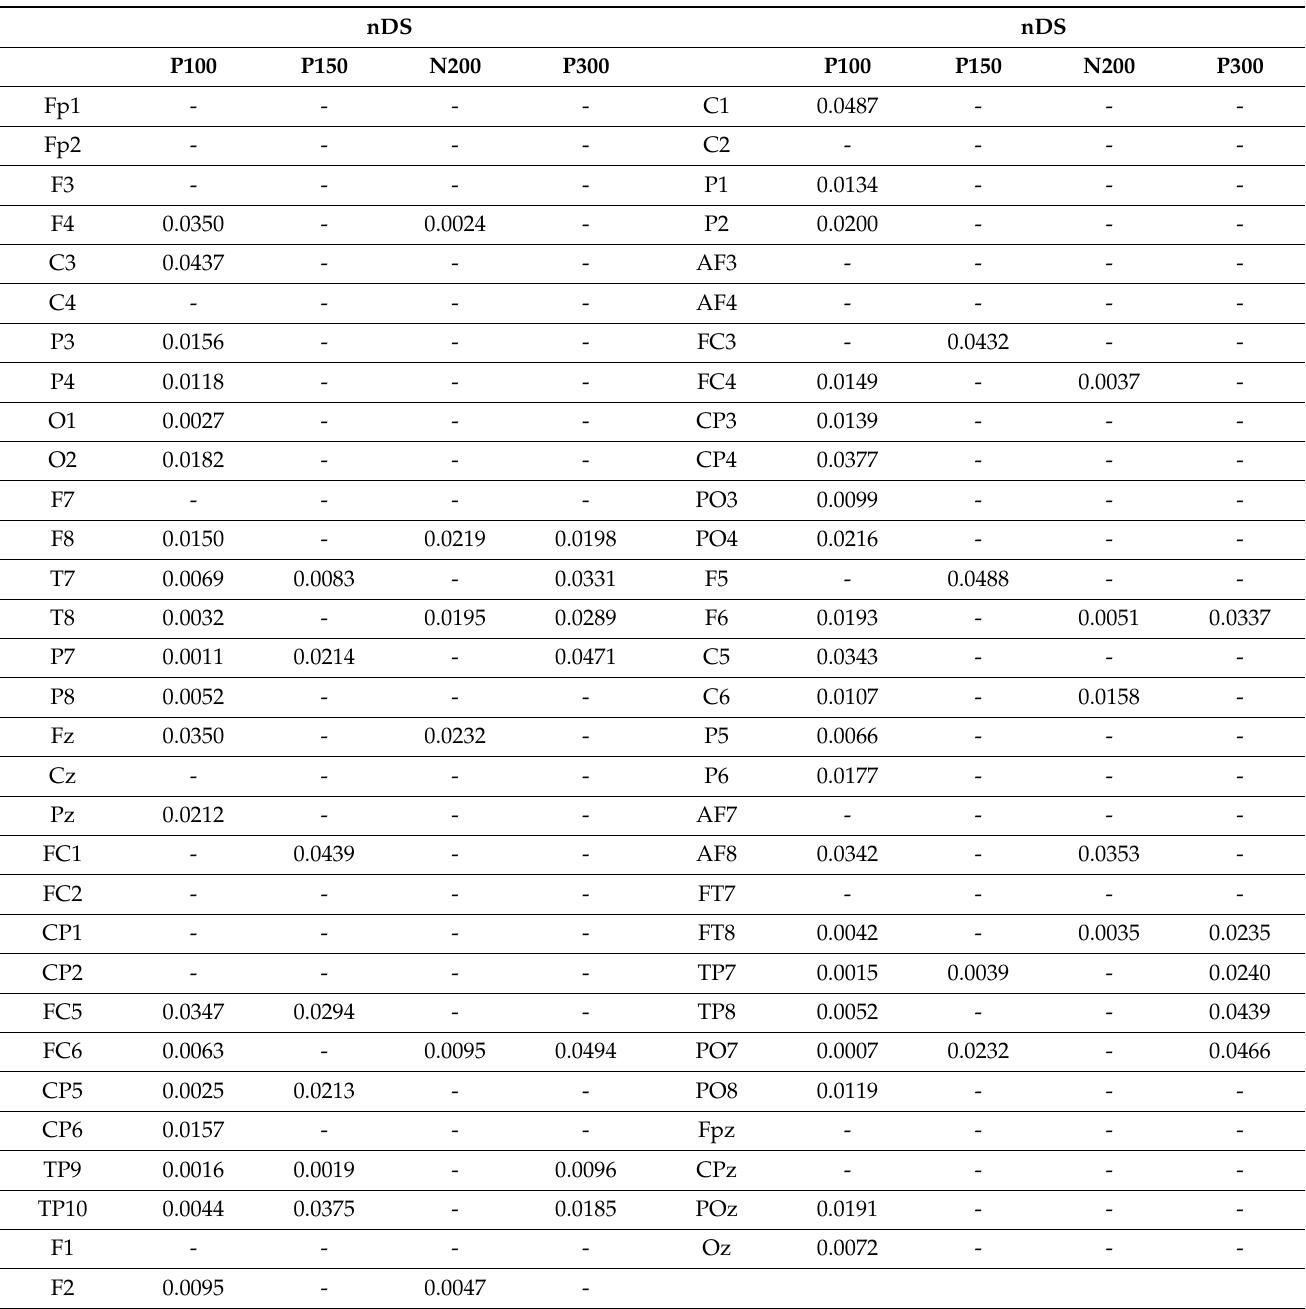
Table 3. Significant values ( p < 0.05) related to all electrodes for P100, P150, N200 and P300 for the go stimulus in the non-directional (nDS) condition between the fast (F) and slow (S) group; “-” indicates non-significant results. The results were corrected using the FDR method to resolve the issue of multiple